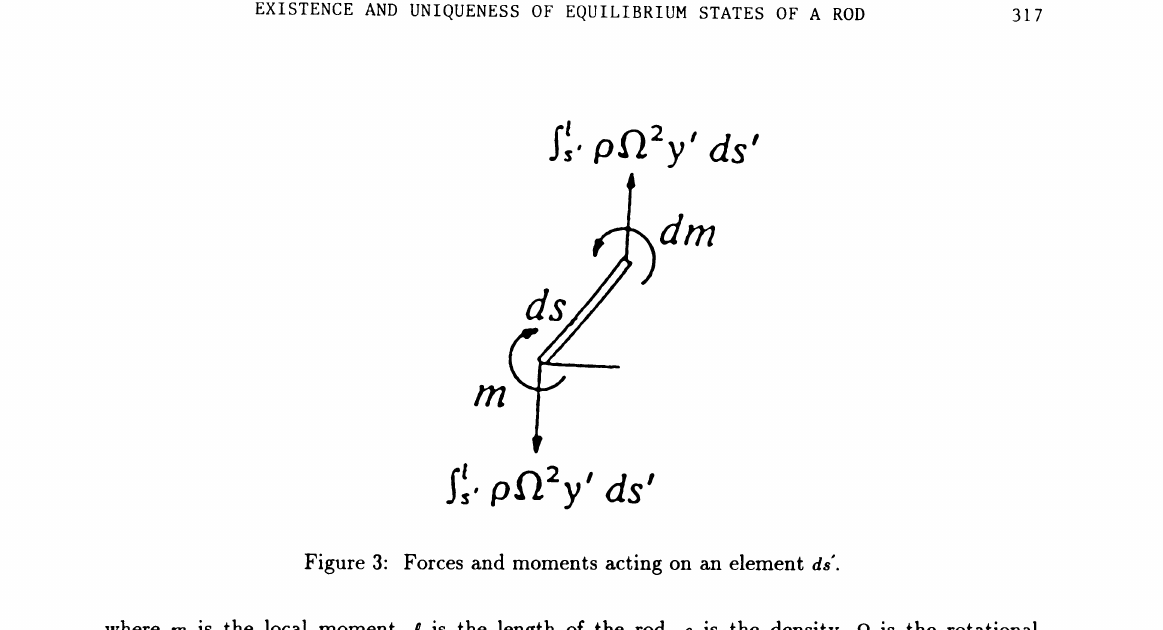
Figure 3: Forces and moments acting on an element